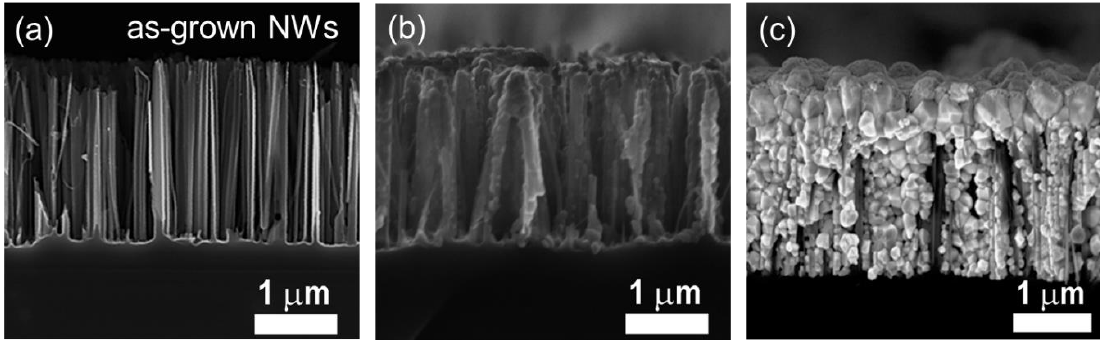
Figure 2. Cross-section SEM images displaying ( a ) a 2-µm long as-grown Si NWs obtained by AgNO 3 MACE, ( b ) a core-shell Si NWs/CuI heterostructure realized by chemical bath deposition for 20 min in a 63 mM solution of CuI diluted in acetonitrile, and ( c ) the Si NWs/CuI heterostructure